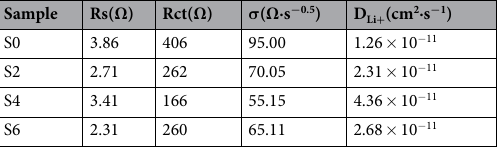
Table 3. The values of Rs, and Rct for the Nyquist plots and calculated Li diffusion coefficient (D Li ) for the samples of different pressure at 25